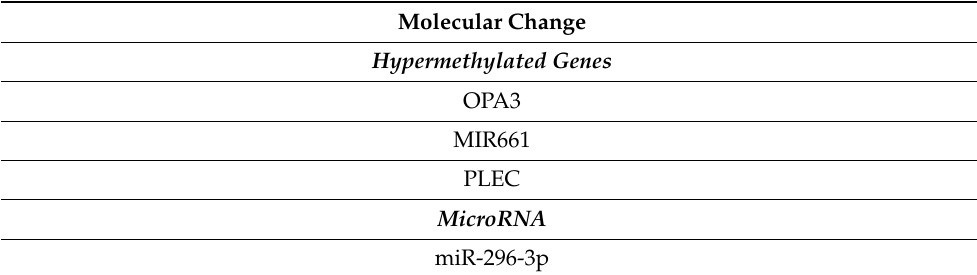
Table 1. Summary of molecular changes implicated in malignant